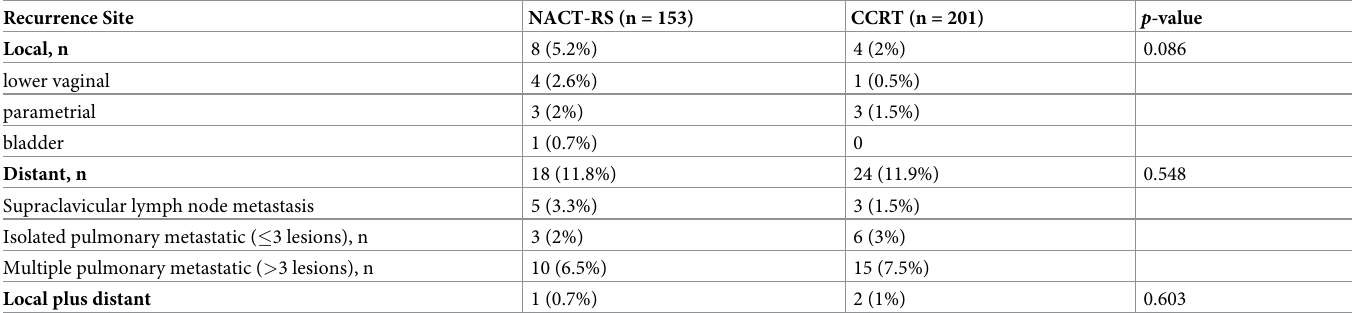
Table 4. Pattern of